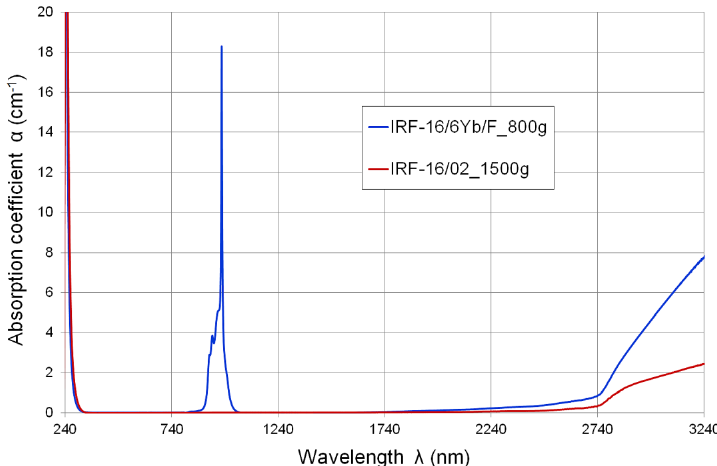
Figure 3. Spectral absorption characteristics of host matrix IRF-16/02 glass and active